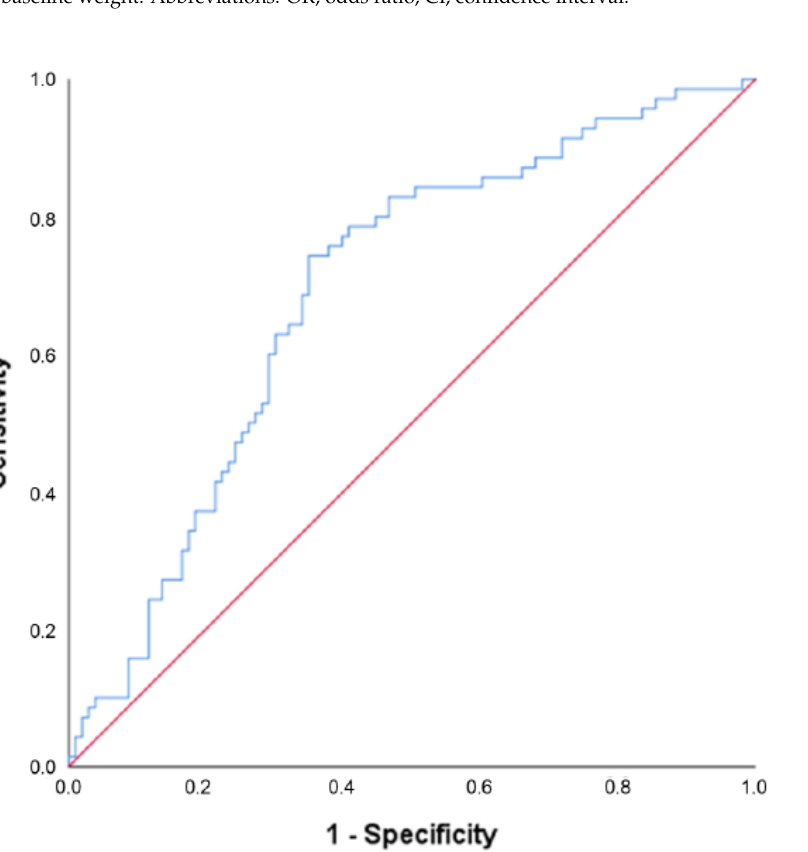
Figure 4. Receiver operating characteristic (ROC) curve for the model predicting conception within 24 months after the start of the intervention resulting in live birth. Note: Results are based on calculations by the Erasmus MC using non-public microdata from Statistics Netherlands. This final model included time attempting to conceive before the start of the study and insulin at baseline, area under the curve = 0.691 ( p <